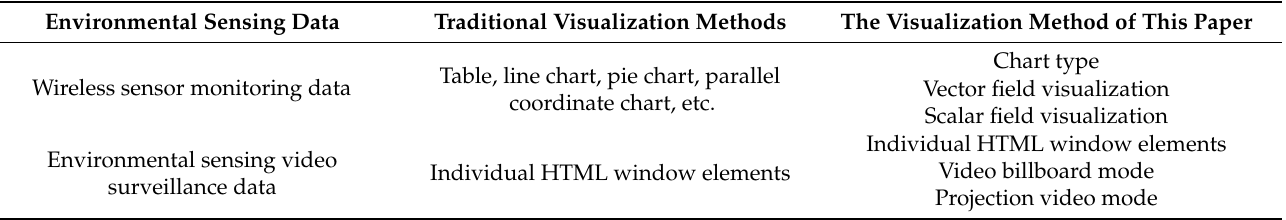
Table 1. Comparison between the traditional visualization of environmental sensing data and the method proposed in this study.